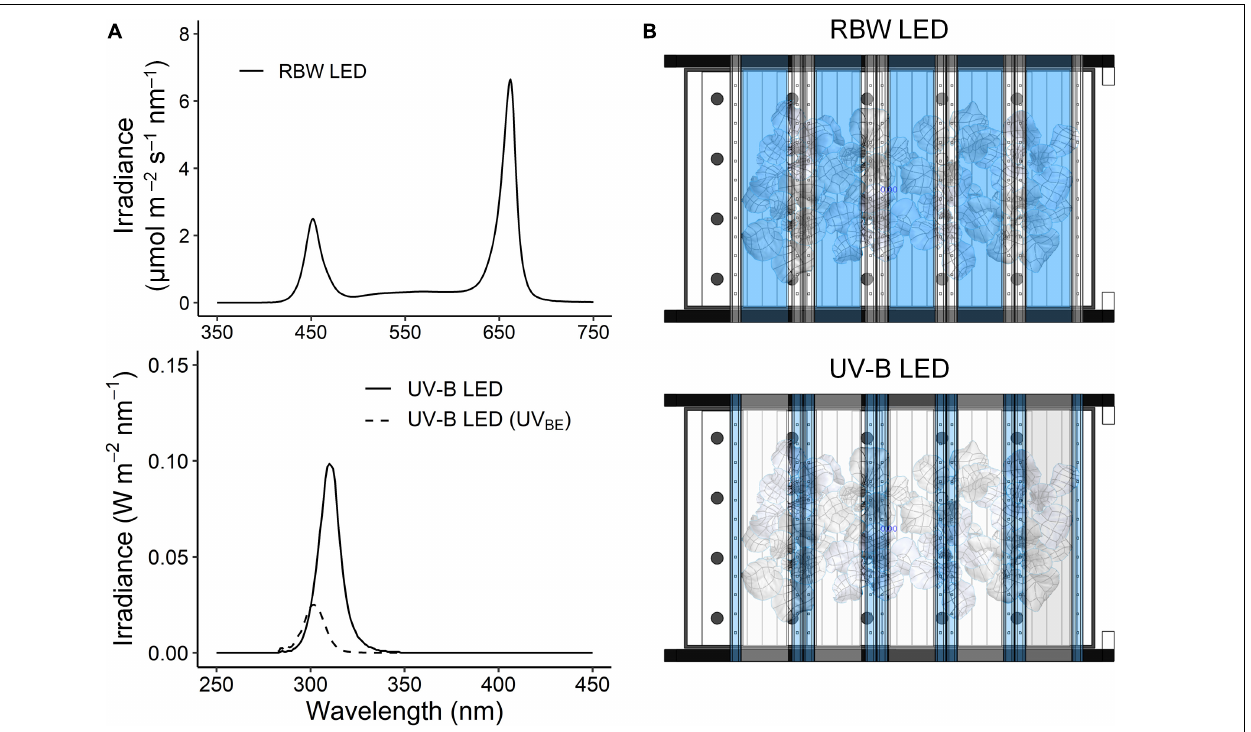
FIGURE 1 | Spectra (A) and arrangement (B) of red, blue, and white light-emitting diodes (RBW LED) and UV-B LED used in the plant factory. The irradiance of UV-B LEDs with a spectral peak at about 310 nm was 3.0 W m – 2 at 280–400 nm. UV-B BE indicates biologically effective UV-B calculated using a biological spectral weighting function for plants (Flint and Caldwell, 2003), and thereby its spectral peak was at about 302 nm. The RBW LEDs irradiated at a photosynthetic photon flux density of 255 µ mol m – 2 s – 1